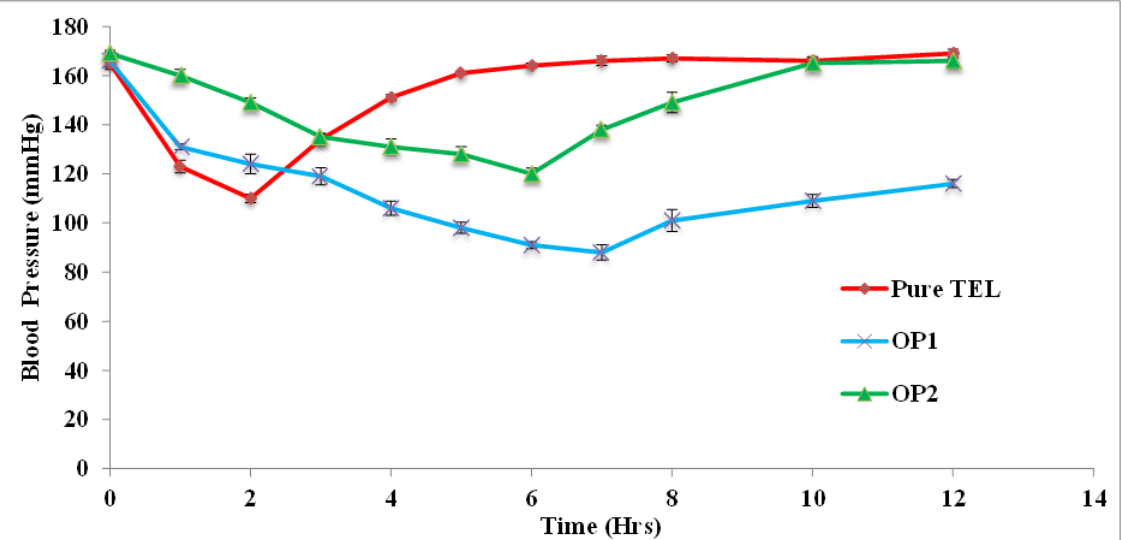
Figure 13. Antihypertensive effect of optimized TEL-loaded beads (OP1 and OP2) in hypertension- induced rats. induced